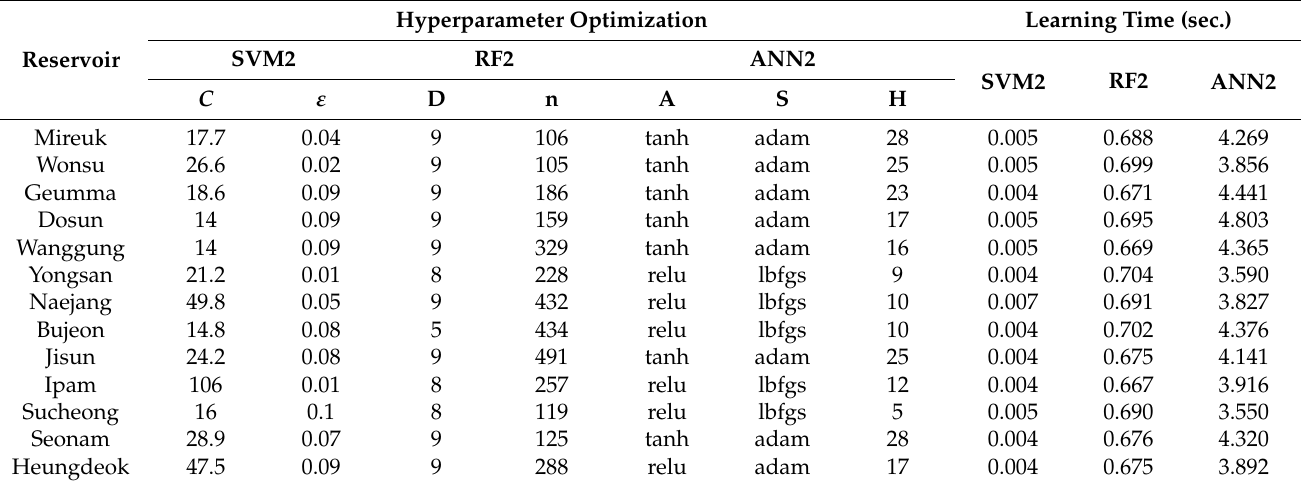
Table 8. Results of best parameters and learning time of models for two-month forecasting.